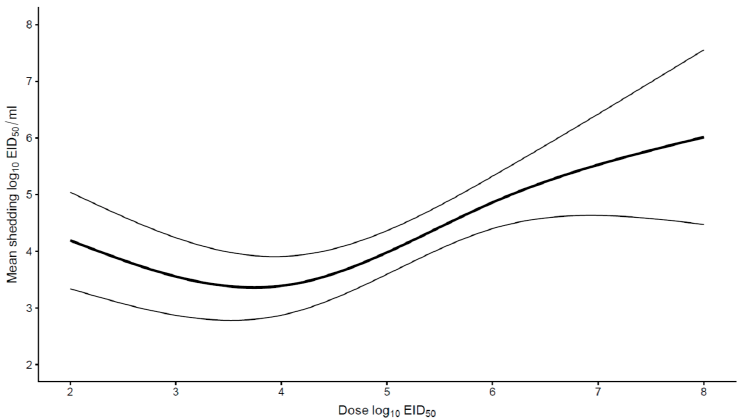
Figure 5. The relationship between the inoculation dose and the mean respiratory and cloacal virus shedding (log 10 EID 50 / mL) for HPAIV in chickens. The mean shedding increased when poultry were inoculated with doses above 10 5 EID 50 .